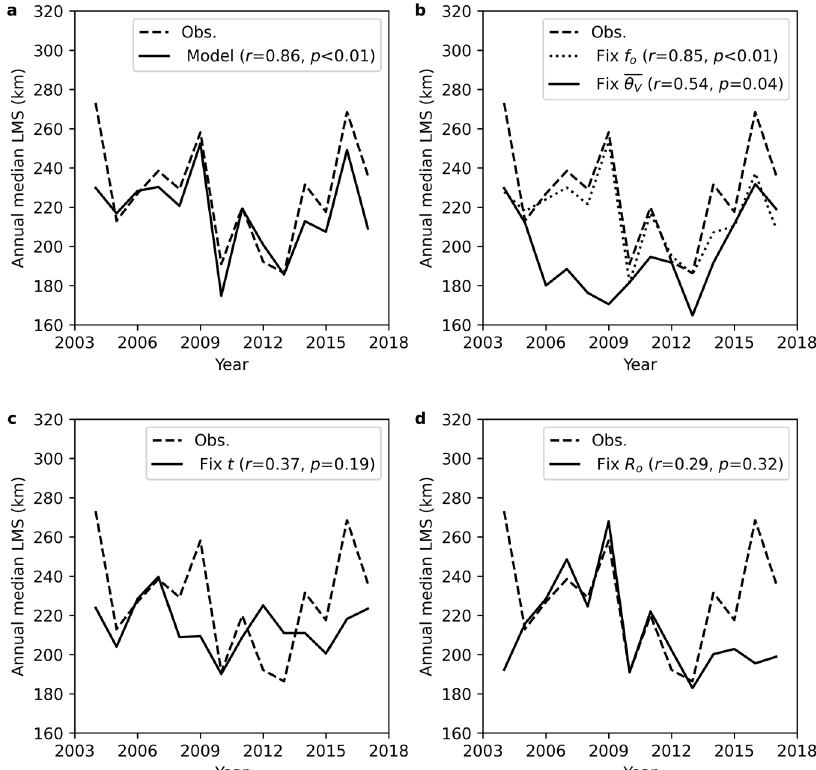
Fig. 5 Global annual LMS. The LMS of each TC is modeled by Eq. (9) with full variables in ( a ), fi xed f o or α V in ( b ), fi xed t in ( c ), and fi xed R o in ( d ). If f o , α V , t or R o is fi xed, the median values of 4.2 × 10 − 5 s − 1 , 0.9 ∘ , 90 h or 83 km is used, respectively. The Pearson correlation coef fi cient ( r ) of the detrended observed and modeled time series are given in the fi gure